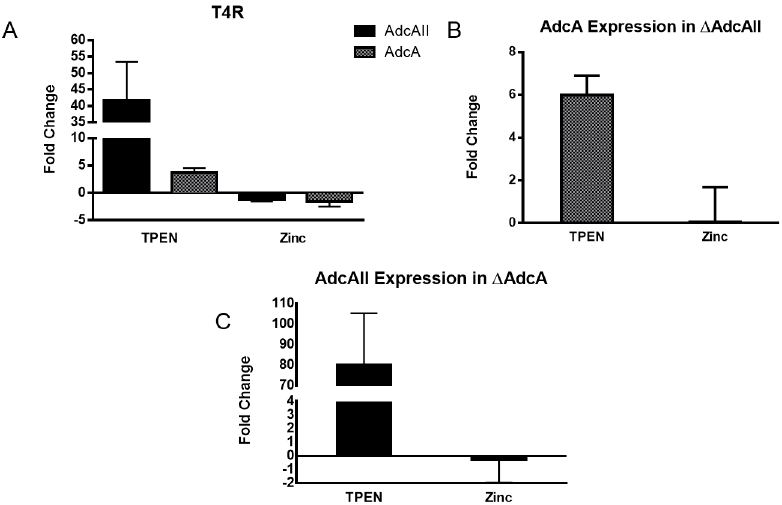
Fig 2. Effects of zinc on expression of adcA and adcAII in zinc rich (100 μ M ZnSO 4 ) or low zinc environment (30 μ M TPEN). A) Expression of adcA (grey) and adcAII [28] in wild type T4R as measured by qRT-PCR ΔΔ CT analysis. B) Expression of adcA in Δ AdcAII. C) Expression of a dcAII in Δ AdcA.